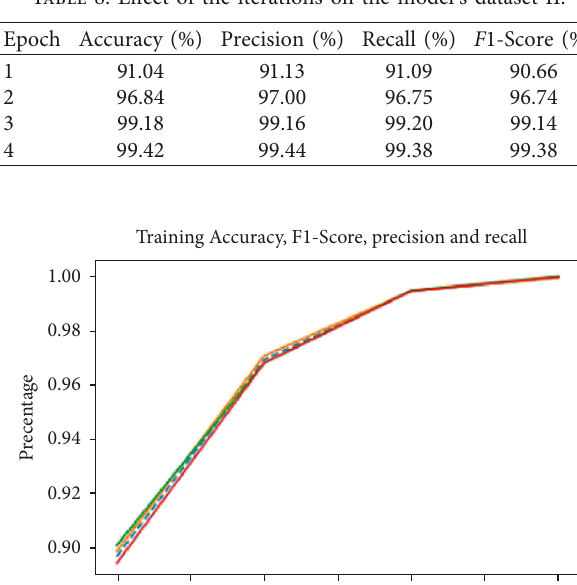
Table 8: Effect of the iterations on the model’s dataset II.